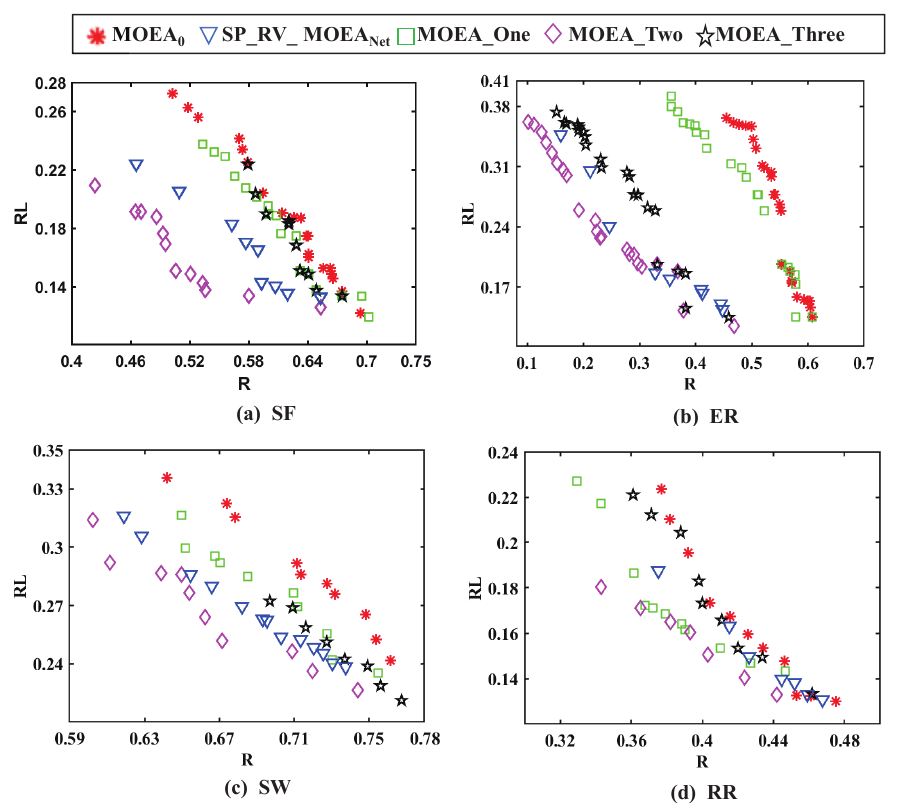
Figure 3. Non-dominated solutions of different methods for four types of complex